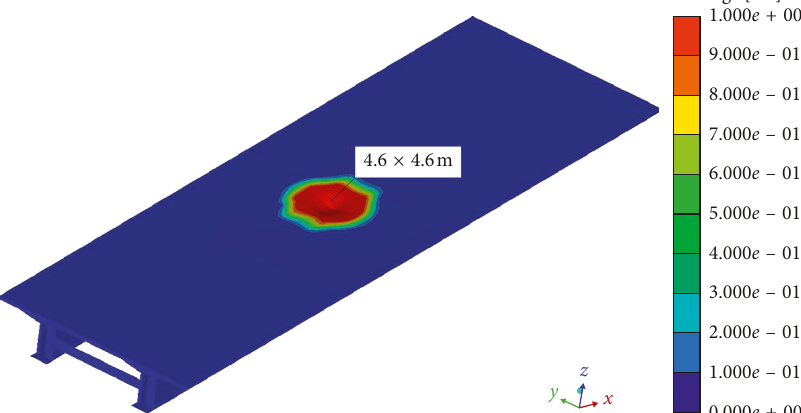
Figure 9: Damage of the bridge.